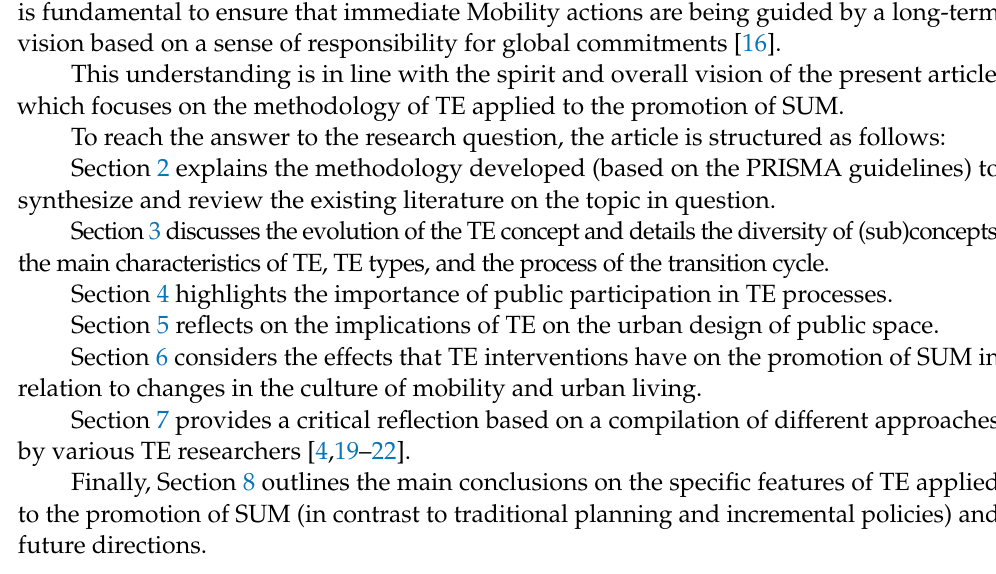
Table 1. Types of research approach of the main publications of TE considered. References of Transition Experiments